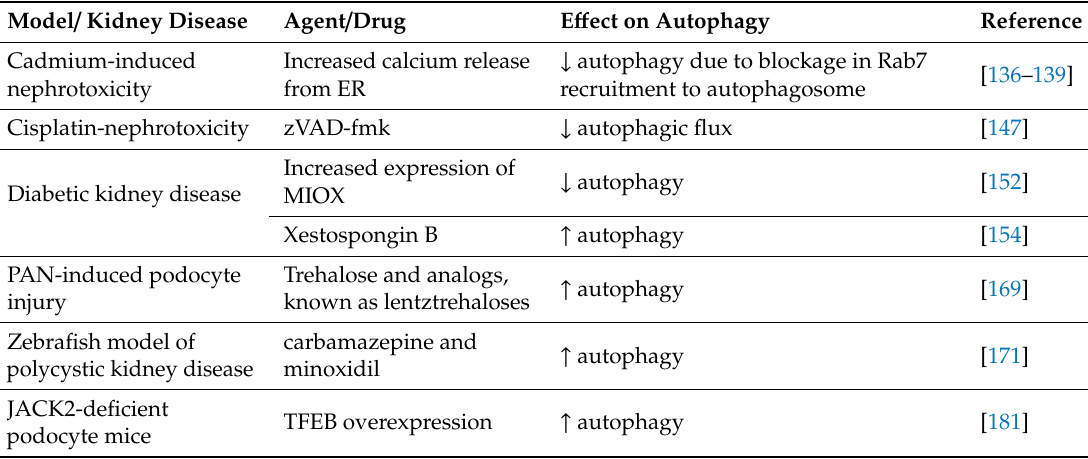
Table 3. mTORC1-independent autophagy regulation in kidney